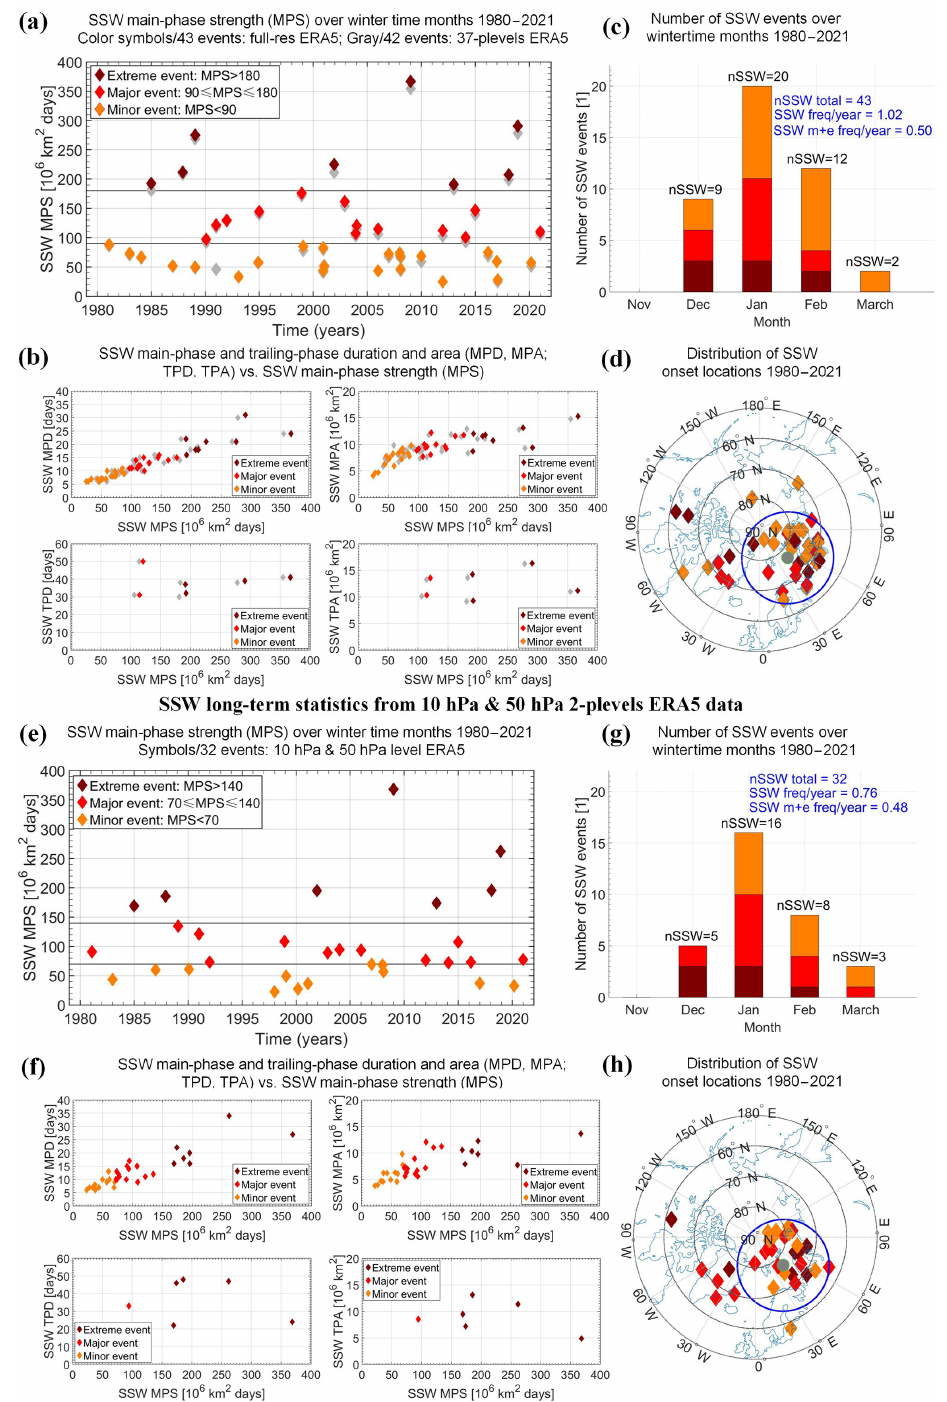
Figure 10. Overview of the main characteristics of the SSW events recorded over the 42 winters from 1980 to 2021 using the new mon- itoring approach based on ERA5 temperature data input at full 137-model-levels resolution (“full-res ERA5”) (upper half, a–d ), coarser standard 37-pressure-levels resolution (“37-plevels ERA5”) (co-illustrated in a and b with gray symbols), or simple two-levels data ex- traction (“10hPa&50hPa level ERA5”) (bottom half, e–h ), respectively. (a, e) Time evolution of main-phase strengths (MPS) (year tick marks denote January of year); (b, f) relation of main-phase and trailing-phase duration and area (MPD, MPA; TPD, TPA) to main-phase strength (MPS); (c, g) distribution of the number of events over the winter months (showing the strength types by the same color as in a and e , b and f ); (d, h) spatial distribution of onset locations, indicating the clustering of more than 75% of the events over the northern Eurasia and polar ocean region by a circle (using, again, the same strength-type colors as in a and e , b and f ). https://doi.org/10.5194/acp-23-1259-2023 Atmos. Chem. Phys., 23, 1259–1284,